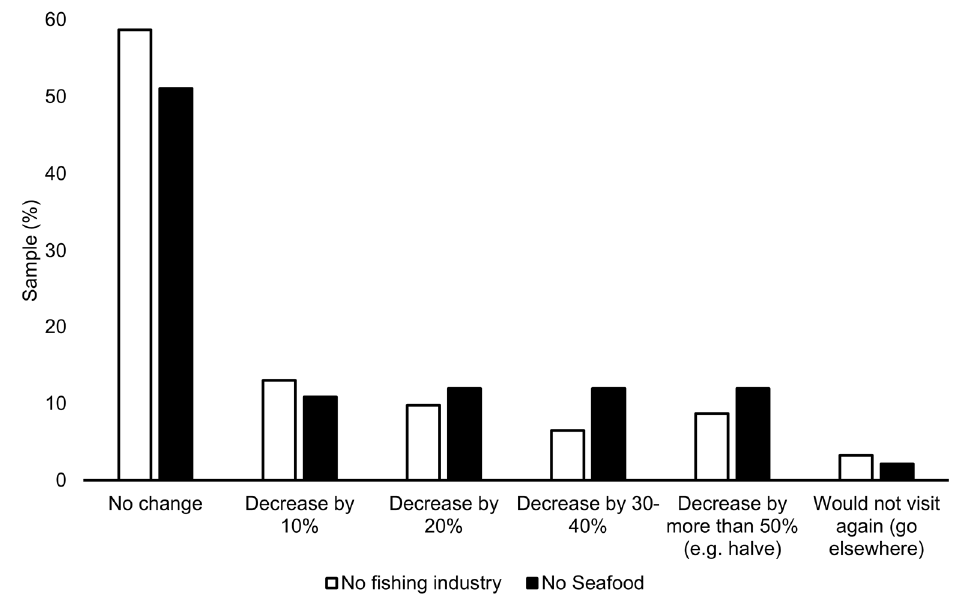
Figure 2. Distribution of responses indicating the expected reduction in the number of trips if there was no fishing industry or locally caught seafood available in Mooloolaba.